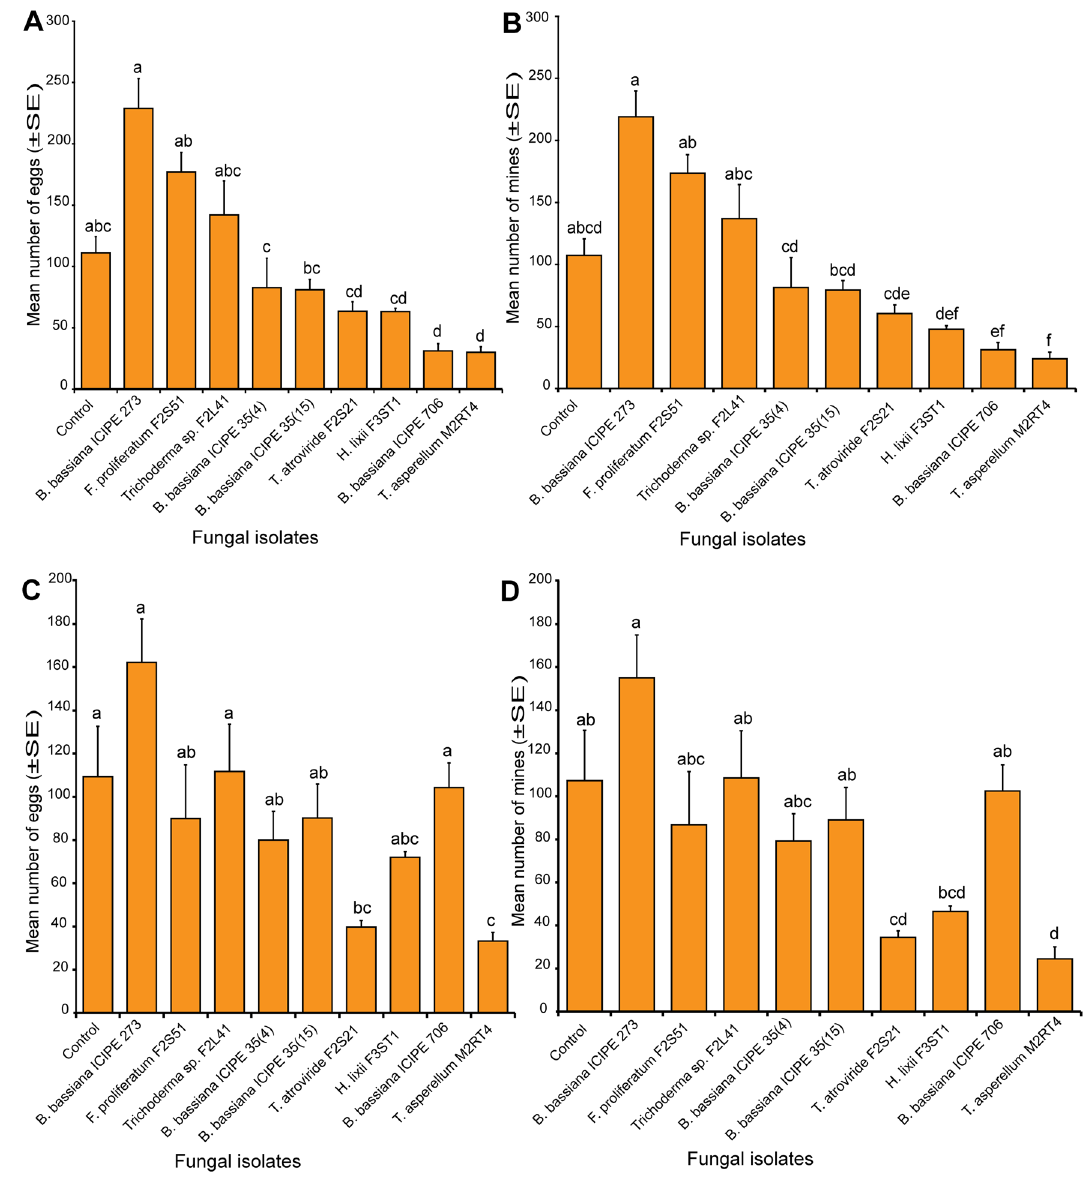
Figure 3. Effect of endophytically-colonized host plants by fungal isolates on oviposition and leafmining of Tuta absoluta at 48 h post-exposure. ( A ) Bar chart showing mean number (± SE) of Tuta absoluta eggs laid on endophytically-colonized tomato plants. ( B ) Bar chart showing mean number (± SE) of mines produced by Tuta absoluta on endophytically-colonized tomato plants. ( C ) Bar chart showing mean number (± SE) of Tuta absoluta eggs laid on endophytically-colonized nightshade plants. ( D ) Bar chart showing mean number (± SE) of mines produced by Tuta absoluta on endophytically-colonized nightshade plants. Means followed by a different lowercase letters are significantly different ( P < 0.05; n = 4; Tukey’s HSD eggs), Trichoderma sp. F2L41 with 142.0 ± 27.67 eggs and the control (111.0 ± 13.32 eggs) (Fig. 3A). Upon egg hatching, T . asperellum M2RT4-endophytically-colonized tomato plants recorded the lowest number of mines (24.0 ± 5.4 mines) while B. bassiana ICIPE 273 recorded the highest number of mines (219.0 ± 20.92 mines) fol- lowed by F. proliferatum F2S51 (173.5 ± 15 mines), Trichoderma sp. F2L41 with 137.0 ± 24.47 mines, compared to 107.33 ± 13.32 mines in the control ( χ 2 = 216.4, df = 9, P < 0.0001) (Fig. 3B). Similarly, endophytically-colonized nightshade plants had a significant effect on the oviposition of T. absoluta ( χ 2 = 91.73, df = 9, P < 0.0001) (Fig. 3C). Among the fungal isolates, the lowest number of eggs was laid on T . asperellum M2RT4 endophytically-colonized nightshade plants (33.25 ± 3.97 eggs) compared to 109.33 ± 23.31 eggs in the control (Fig. 3C). However, the highest number of eggs (162.25 ± 20.01 eggs) was recorded on B. bassiana ICIPE 273, followed by Trichoderma sp. F2L41 with 111.75 ± 21.85 eggs and B. bassi- ana ICIPE 706 (104.25 ± 11.38 eggs), compared to 109.33 ± 23.31 eggs in the control (Fig. 3C). Subsequently, following egg hatchability, the lowest number of mines (24.5 ± 5.55 mines) was recorded on T . asperellum